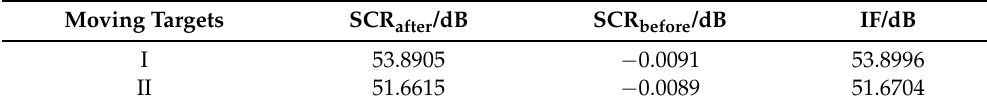
Figure 9. The processing results of multilayer channel-cancellation on simulated HRWS SAR data of point-target, which is shown in Figure 8, ( a ) the first layer of channel cancellation, ( b ) the second layer of channel cancellation, ( c ) the third layer of channel cancellation, ( d ) the forth layer of channel cancellation, ( e ) the last layer of channel cancellation. Table 2. SCR and IF of the simulated moving